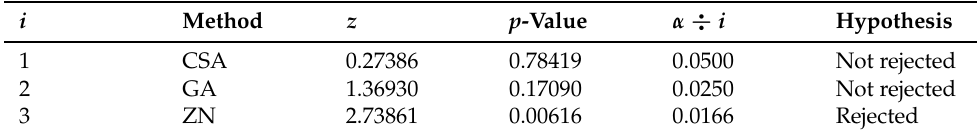
Table 5. Results of Holm’s method based on the overshoot